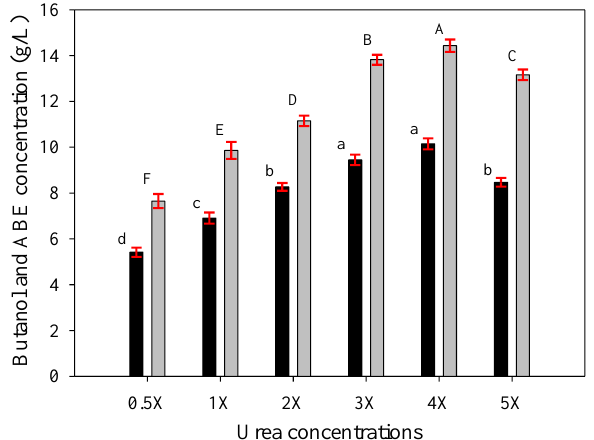
Figure 3. Butanol (black bars) and ABE (gray bars) contents of butanol fermentation from SSJ medium supplemented with various urea concentrations by free cells (1X = 0.16 g/L of urea) at the fermentation time of 48 h. The error bars represent the standard deviation of the mean values. Bars associated with the same letter have no significant differences assessed by Duncan's multiple range test with a critical value of 0.05.